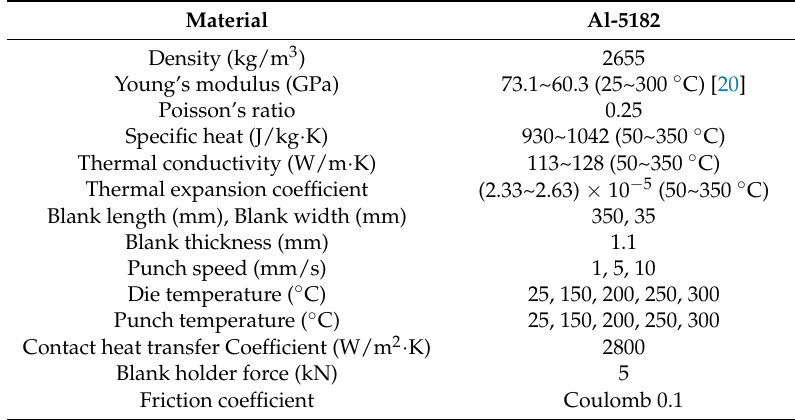
Table 1. The FEM (finite element method) simulation conditions.